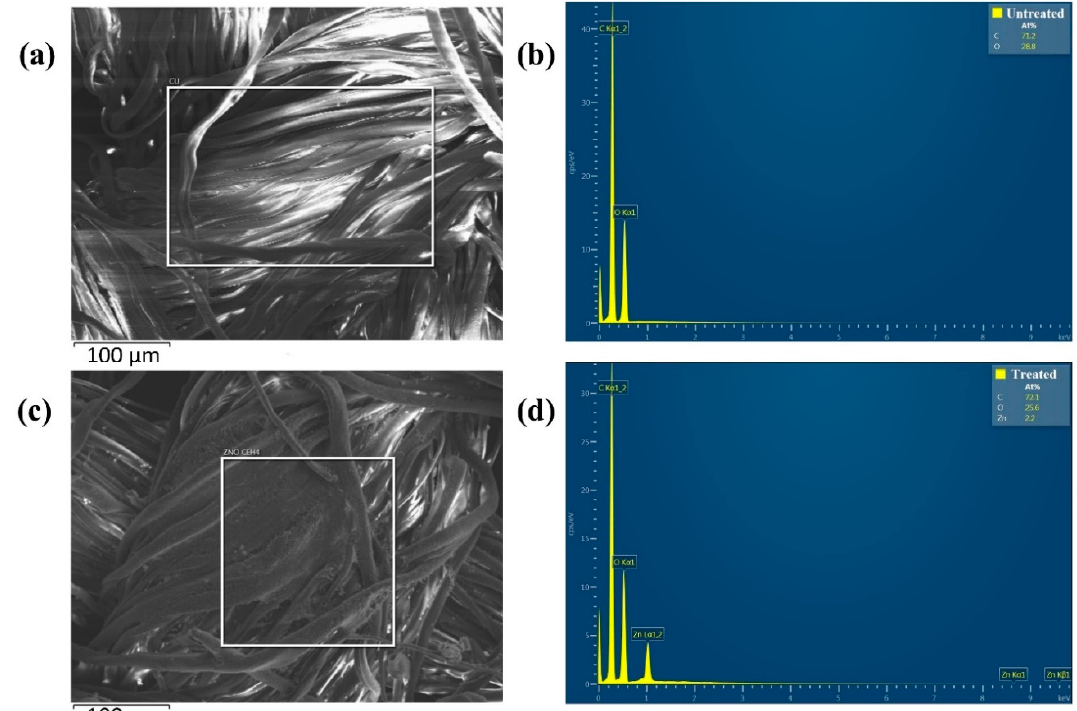
Figure 3. EDX analysis of ( a ) the untreated sample (the rectangular part shows a smooth and clear surface), ( b ) EDX spectrum of untreated sample, ( c ) sample C-nZnO 1 (the rectangular part shows the existence of nZnO as a thick condense layer on cotton, and ( d ) EDX spectrum of sample C-nZnO 1.